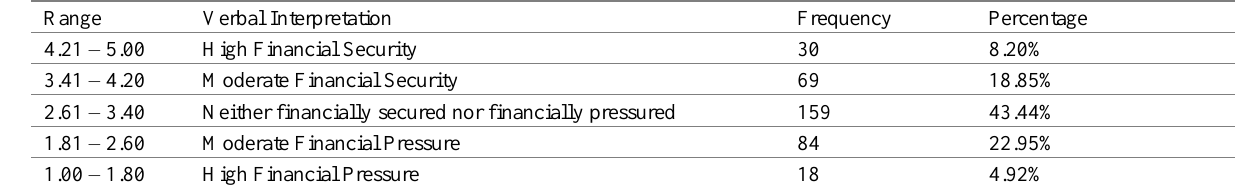
Table 1 : Level of Financial Well-being of HEI Teachers in Region 1.